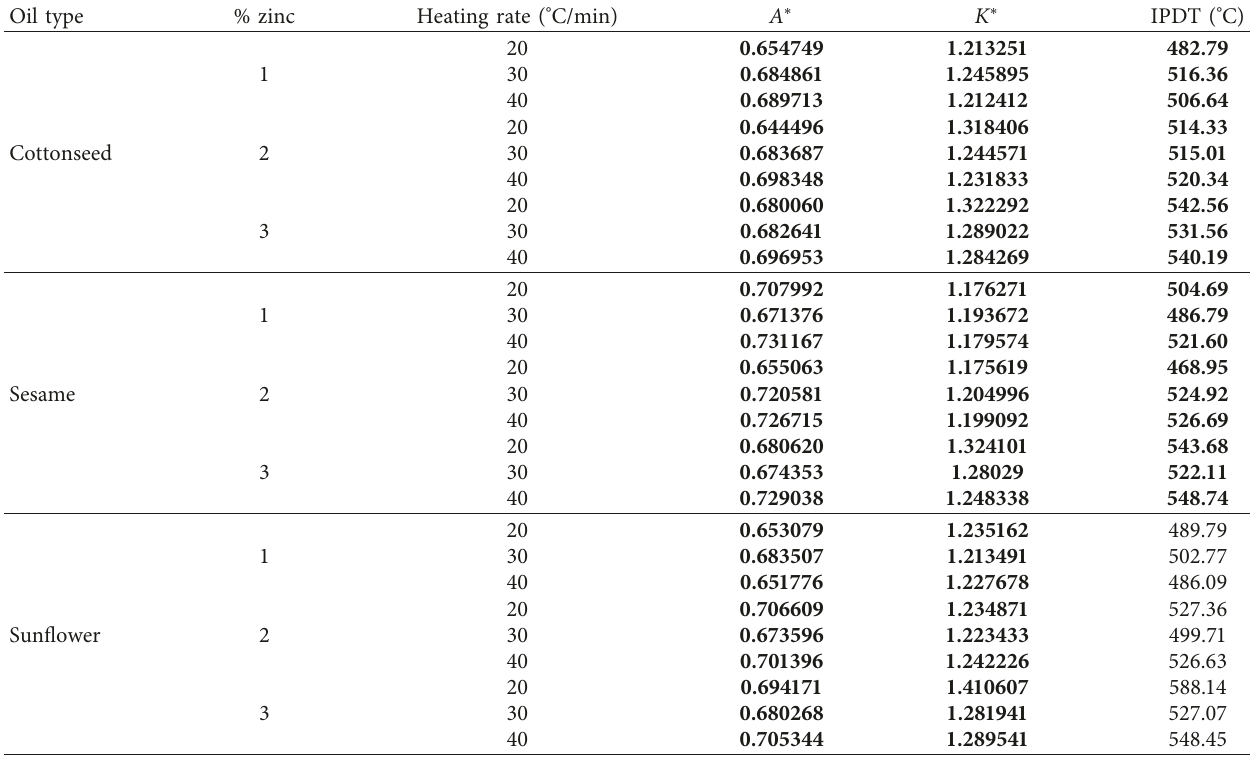
Table 3: A ∗ , K ∗ , and IPDT values of gluten-based epoxy resin.